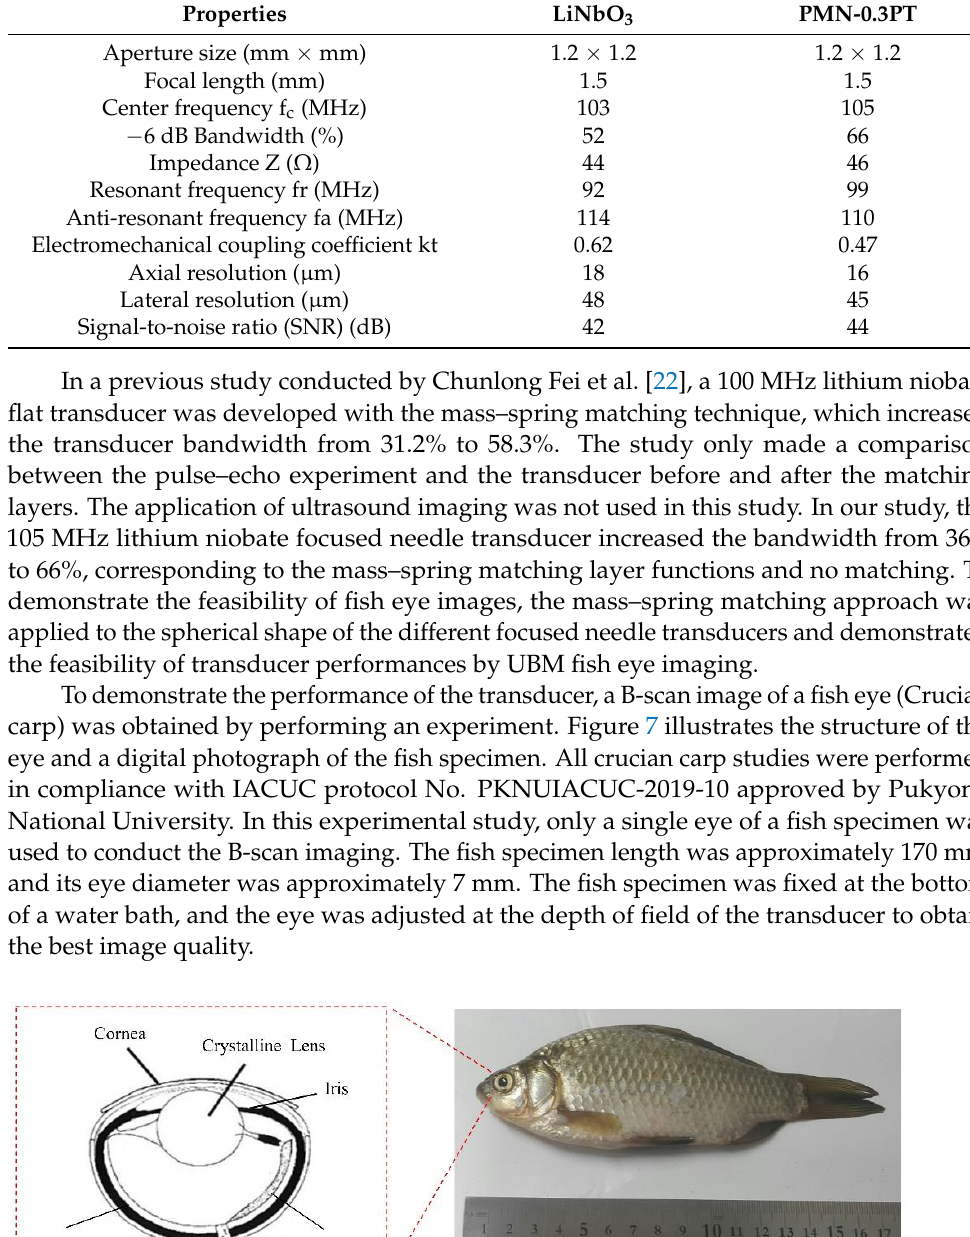
Table 4. Measured transducer characteristics.